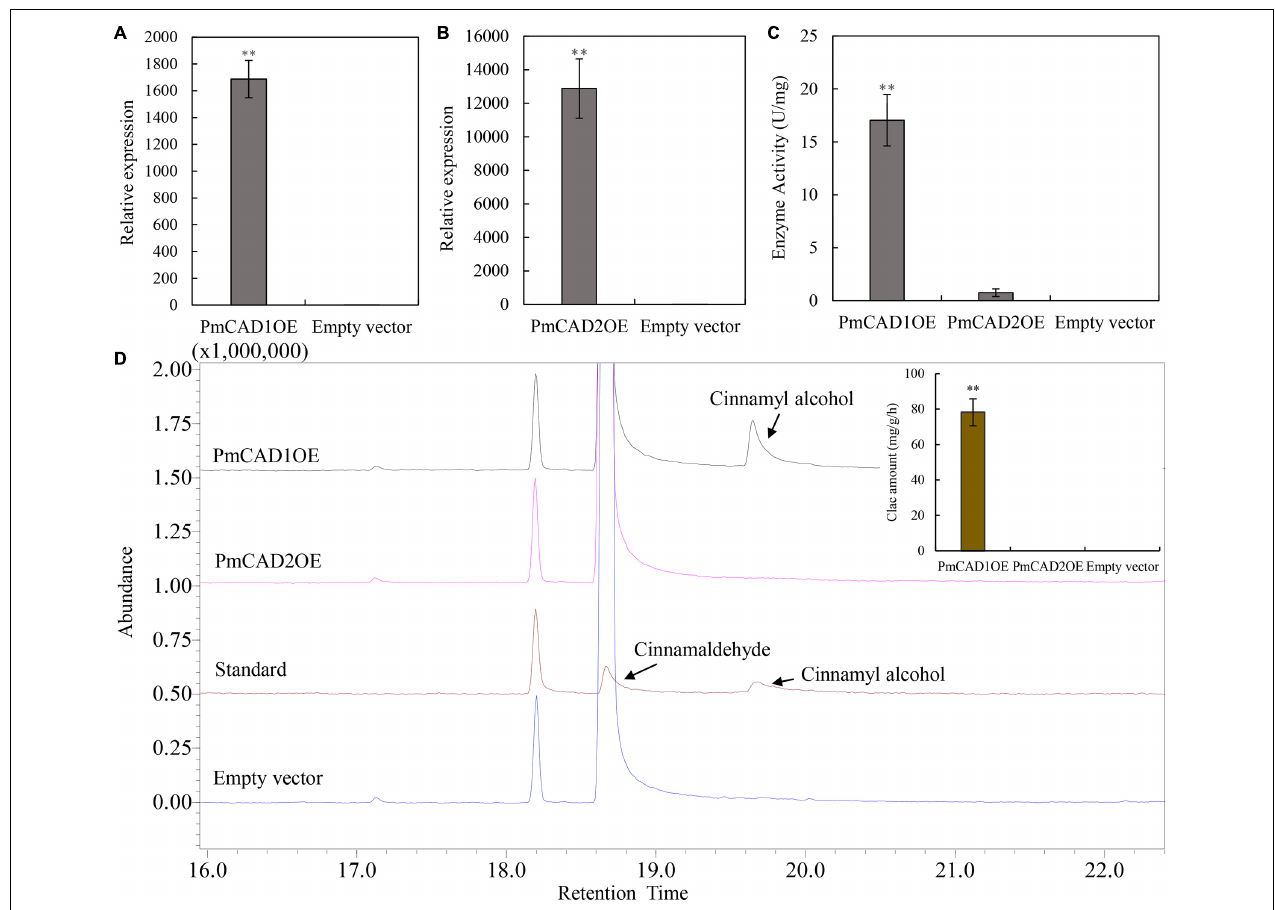
FIGURE 7 | Enzyme activity analyses of PmCAD1 and PmCAD2. (A,B) Expression level of genes in tobacco leaves overexpressing PmCAD1 and PmCAD2 , respectively. (C) Enzyme activity of PmCADs expressed as changes in absorbance. (D) Reaction product detection with cinnamaldehyde as the substrate using GC-MS. Clac, cinnamyl alcohol. The value is the mean of three biological replicates and SE is shown in the bar chart. ∗∗ Represents the significance differences ( p < 0.01). PmCAD1OE represents a tobacco leaf sample overexpressing PmCAD1 ; PmCAD2OE represents a tobacco leaf sample overexpressing PmCAD2 ; empty vector represents a tobacco leaf sample overexpressing an empty